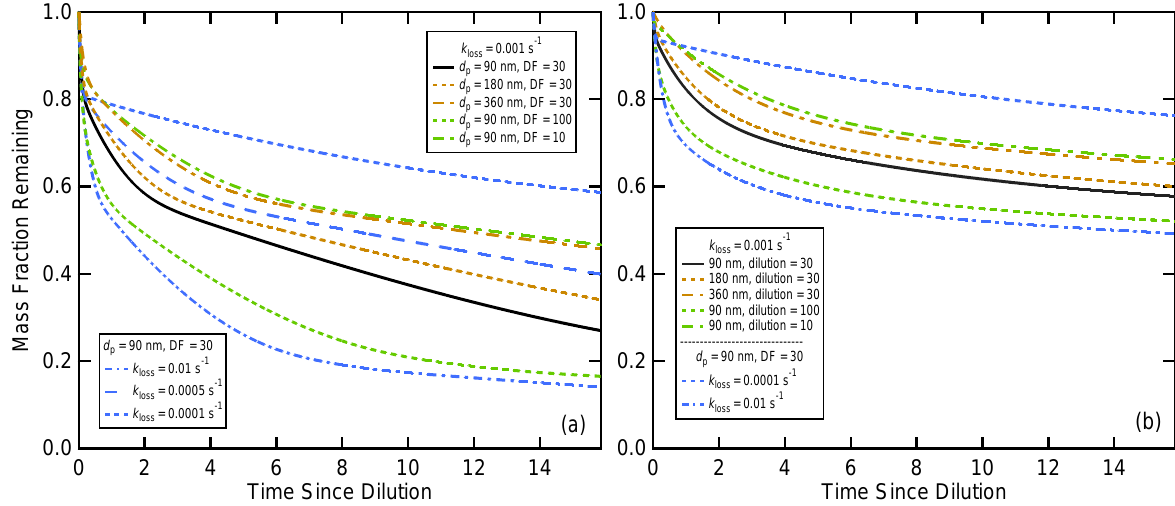
Figure 7. Dependence of the isothermal evaporation simulations on the assumed vapor loss rate ( k loss ) , dilution factor (DF) or particle diameter ( d p ) for (a) the dimer-decomposition and (b) the low-volatility models. All simulations were run for an initial C OA = 100µgm − 3 . For the dimer-decomposition model, the K eqm = 10 − 16 cm 3 molecule − 1 best-fit results were